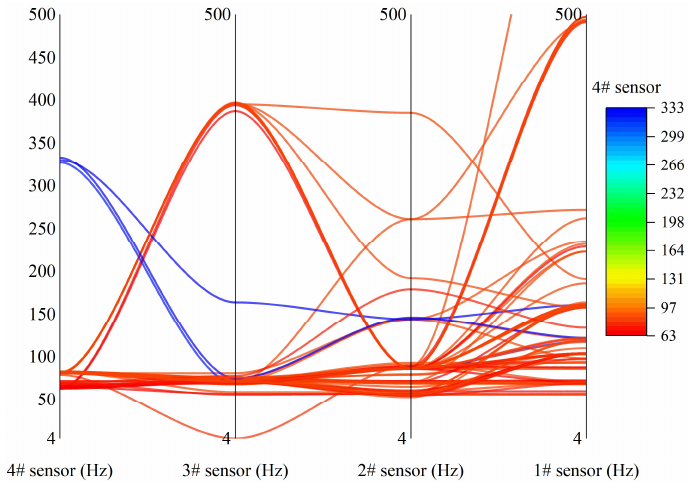
Figure 10. Main frequency variation of each statistical event.